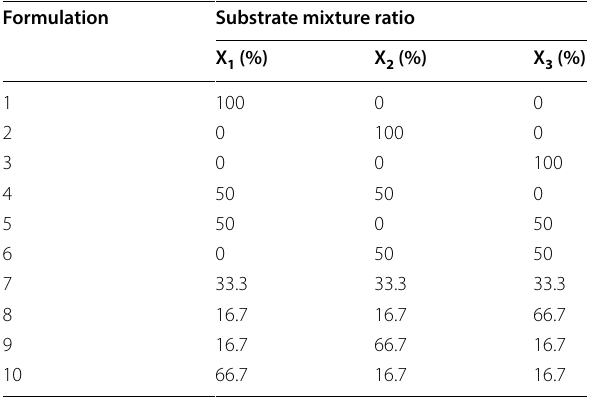
Table 1 Experimental design and model formulations for cultivation